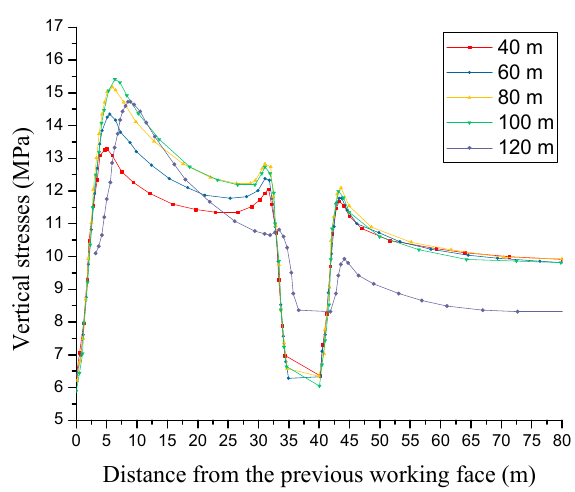
Figure 13. Vertical stress distribution curves with different excavation distances (m).